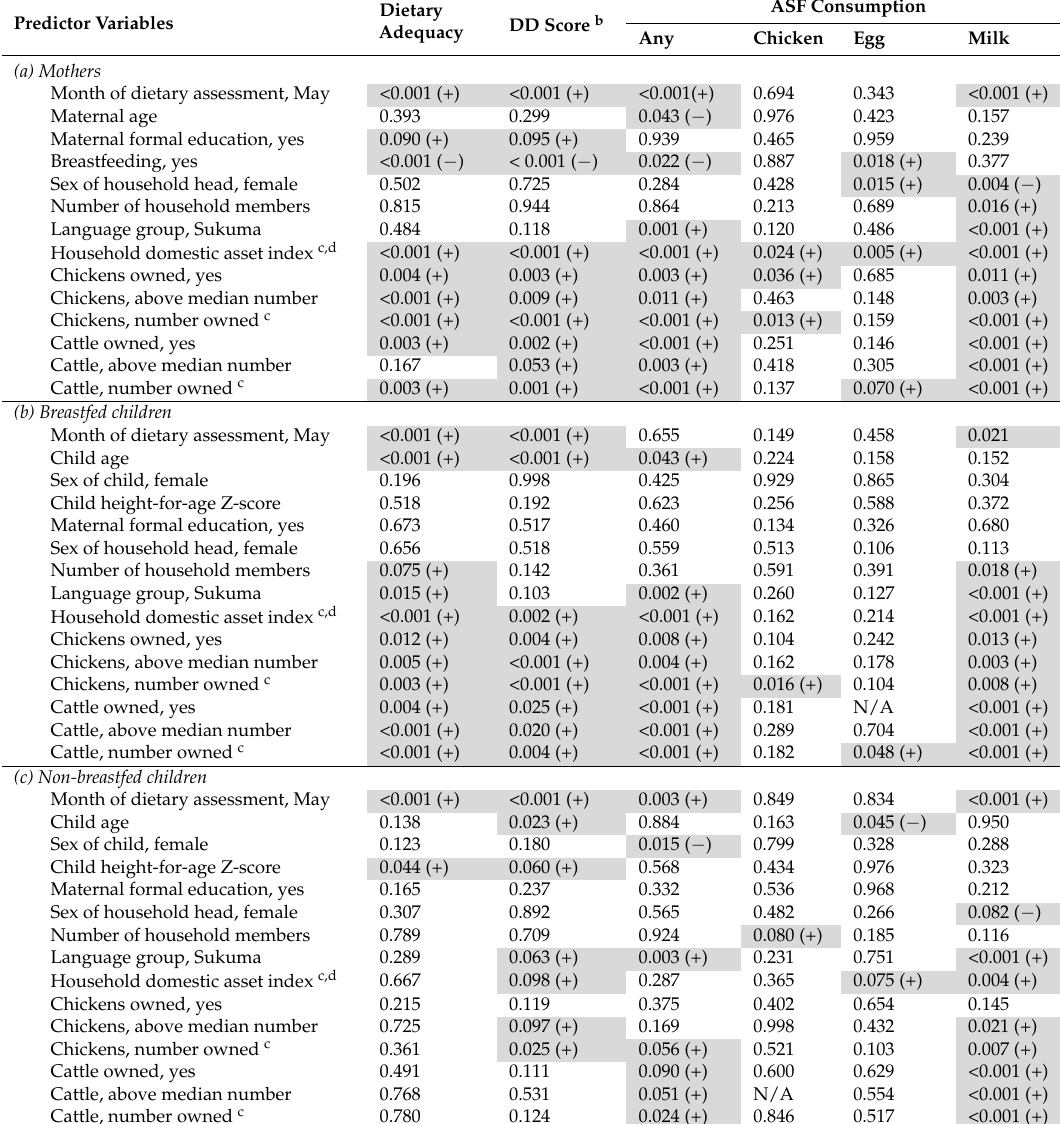
Table A2. Univariable models a evaluating the significance of predictor variables for maternal and child dietary adequacy, dietary diversity and ASF consumption, showing p -values and the direction of associations (+/ − ). Grey shading indicates all suggestive associations ( p <